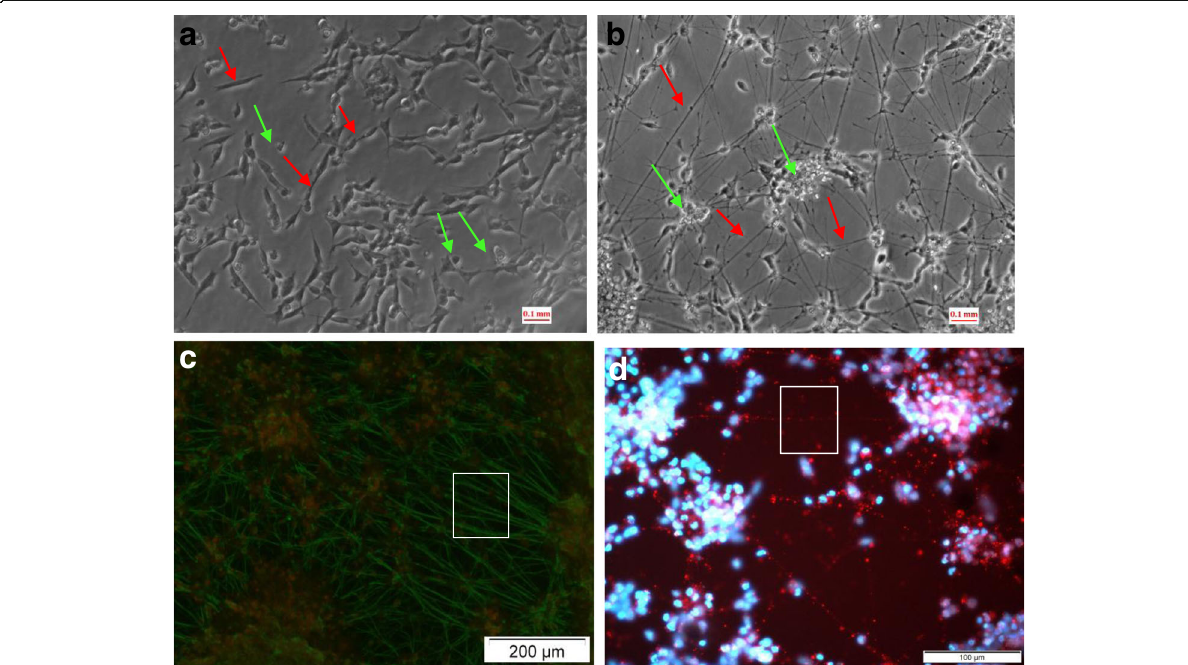
Fig. 2 Images of IMR32 cells. a Phase contrast image of undifferentiated human neuroblastoma IMR32 cells. Its shows proliferating cells. The red color arrows indicate fibroblast type cells and green . Color arrow indicate neuroblast type cells. b 2.5 μ M Brdu differentiated human IMR32 cells (Div15 days). It shows neuron like properties including neuritic outgrowth and morphological changes. Red arrows shows the elongated neurites, green arrows connected clumps of cells. c ICC image of the expression of class III Beta-tubulin neuron marker in Div15 dIMR32 cells. Nuclei stained in Propidium iodide (PI red ) and post mitotic neurons staining with class III β -tubulin ( green ). d Expression of ChAT (Choline Acetyltransferase) cholinergic neuron cell marker in dIMR32 cells. Nuclei stained with DAPI ( blue ) and cholinergic neurons stained with ChAT ( red